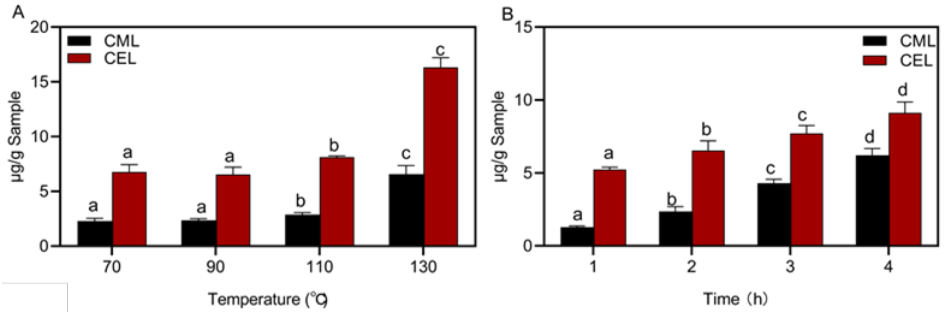
Figure 1. Effect of processing temperature and time on CML and CEL. ( A ) temperature; ( B ) time. Different letters above the bars indicate significant differences (n = 3, p < 0.05). N ɛ -carboxymethyl lysine (CML) and N ɛ -carboxyethyllysine (CEL).